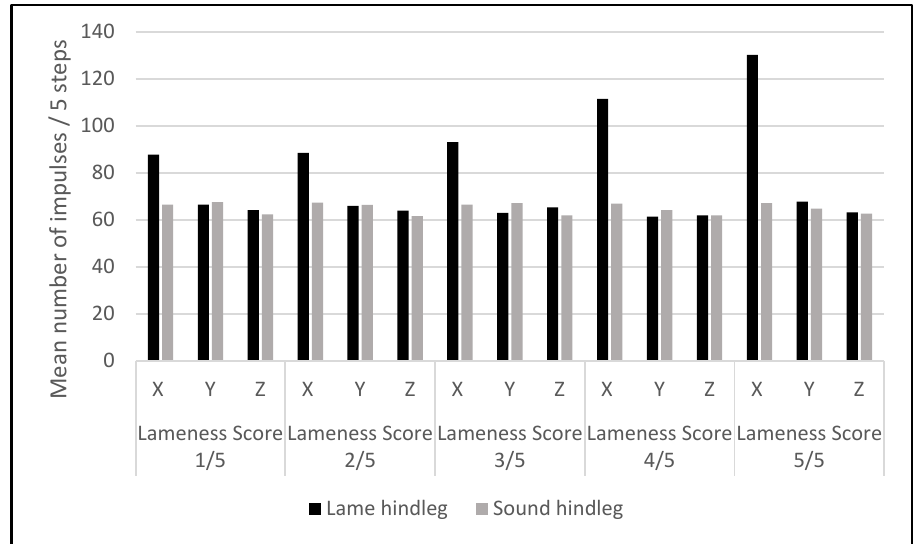
Figure 6. Mean numbers of impulses for five consecutive steps recorded by the Lameness Detector 0.1 in the sound and lame hind ‐ legs with different lameness scores.